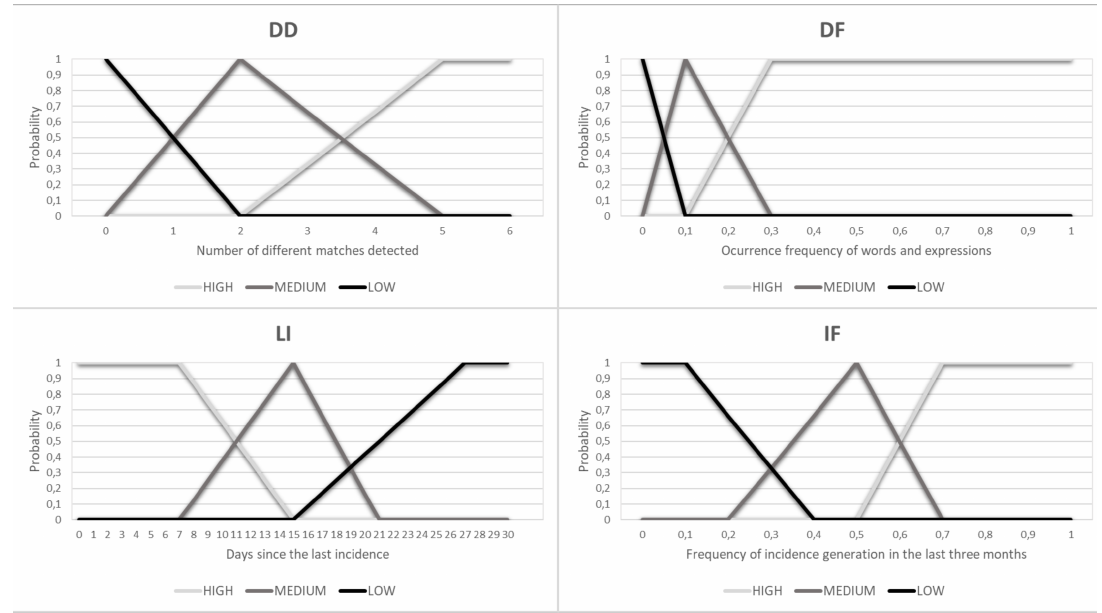
Figure 5. Graphs where the linguistic terms for each linguistic variable are